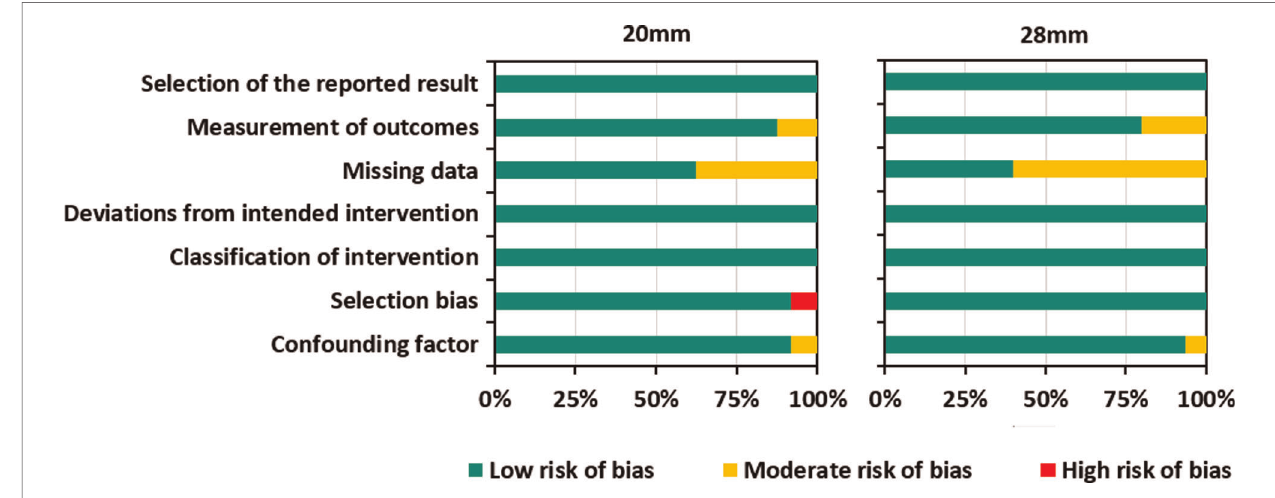
FIGURE 2 | Results of the risk of bias assessment for both